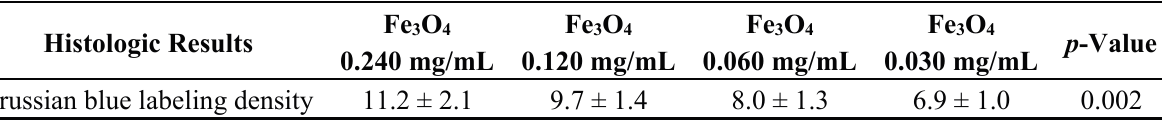
Table 2. The Prussian blue labeling density in LNCaP tumor bearing mice injected with